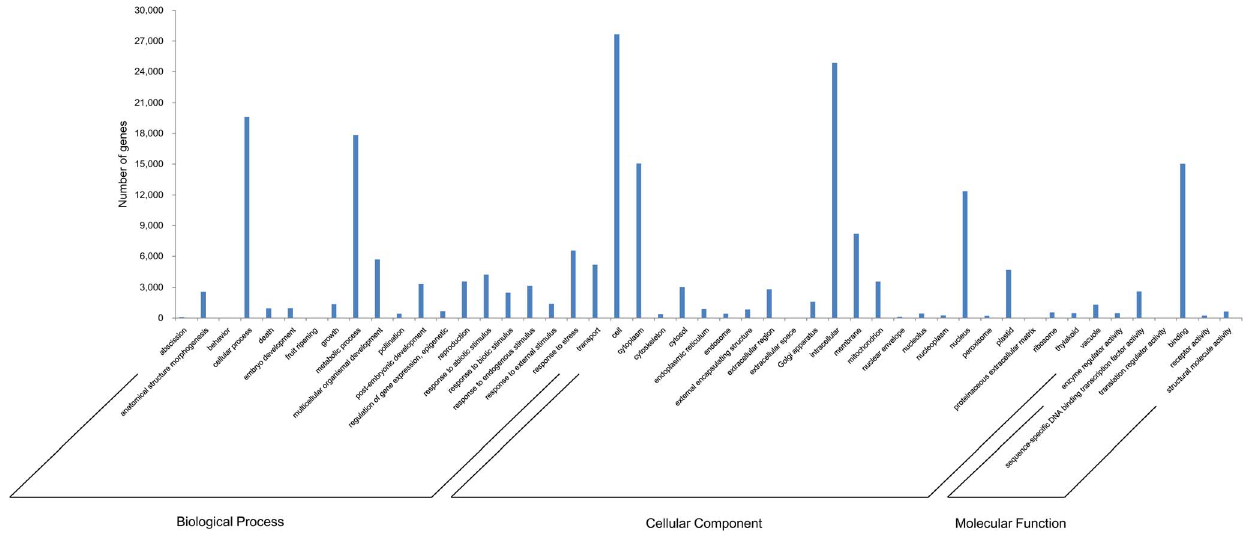
Figure 3. Histogram of the GO classification. The cabbage loci were annotated in three ontology categories: ‘Biological Processes’, ‘Cellular Component’, and ‘Molecular Function’.